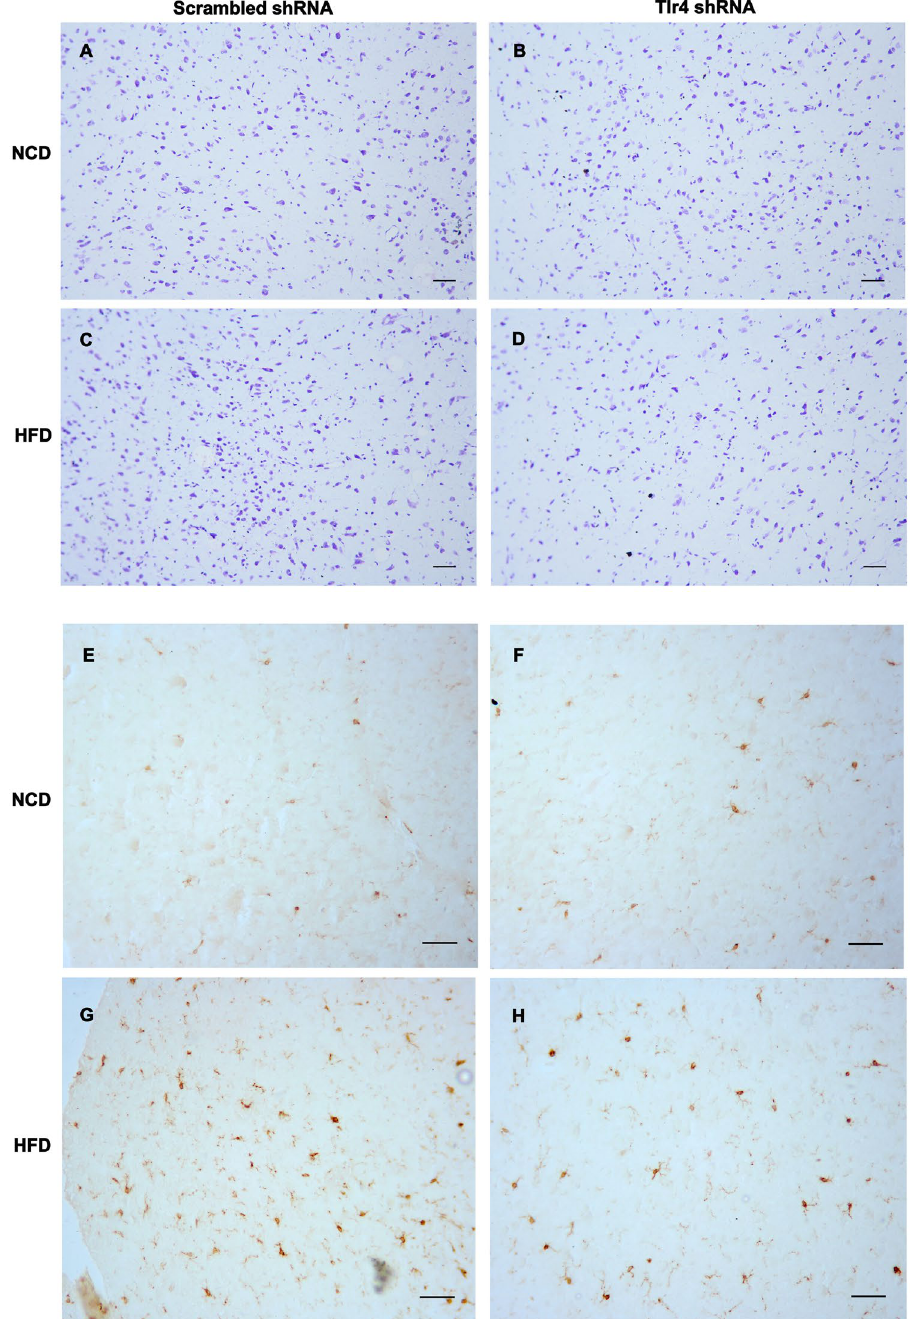
Figure 5. The morphological change of the hypothalamic ARC after down-regulation of Tlr4 mRNA by lentiviral particles (Nissl’s staining) ( A – D ); Down-regulation of Tlr4 mRNA reverses HFD-induced microglia proliferation in the hypothalamic ARC (Microglial cells labeled with Iba1) ( E – H ), Scale bars, 100 μ m. NCD: normal chow diet group; HFD: high fat diet